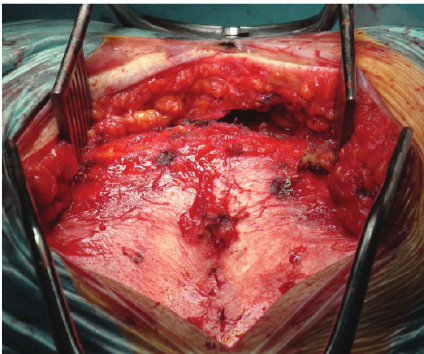
Figure 3: Exposition of dorsal fascia from lumbosacral junction to the tip of the coccyx.